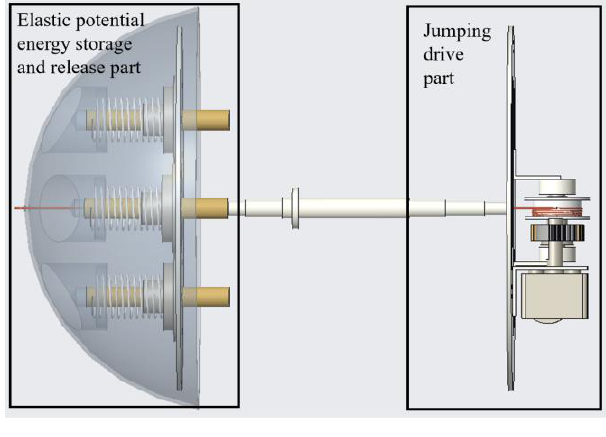
Figure 6. Structure diagram of the jumping module.